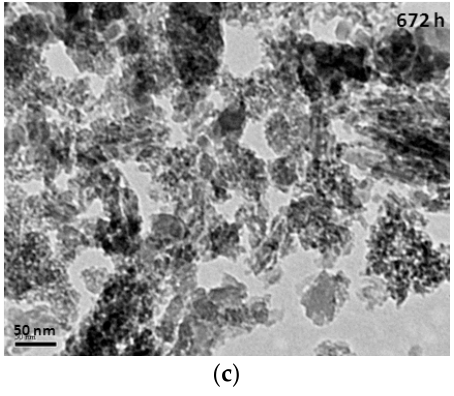
Figure 6. TEM images of mesoporous silica at the hydrolysis-ageing periods of 24 h ( a ), 120 h ( b ) and 672 h ( c ).